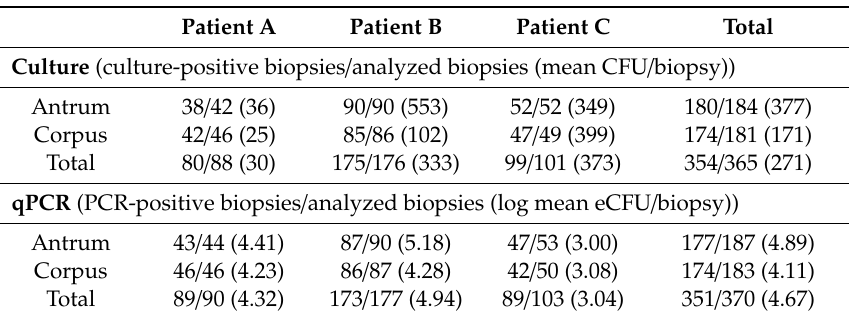
Table 2. Bacterial load estimated by culture and quantitative real-time